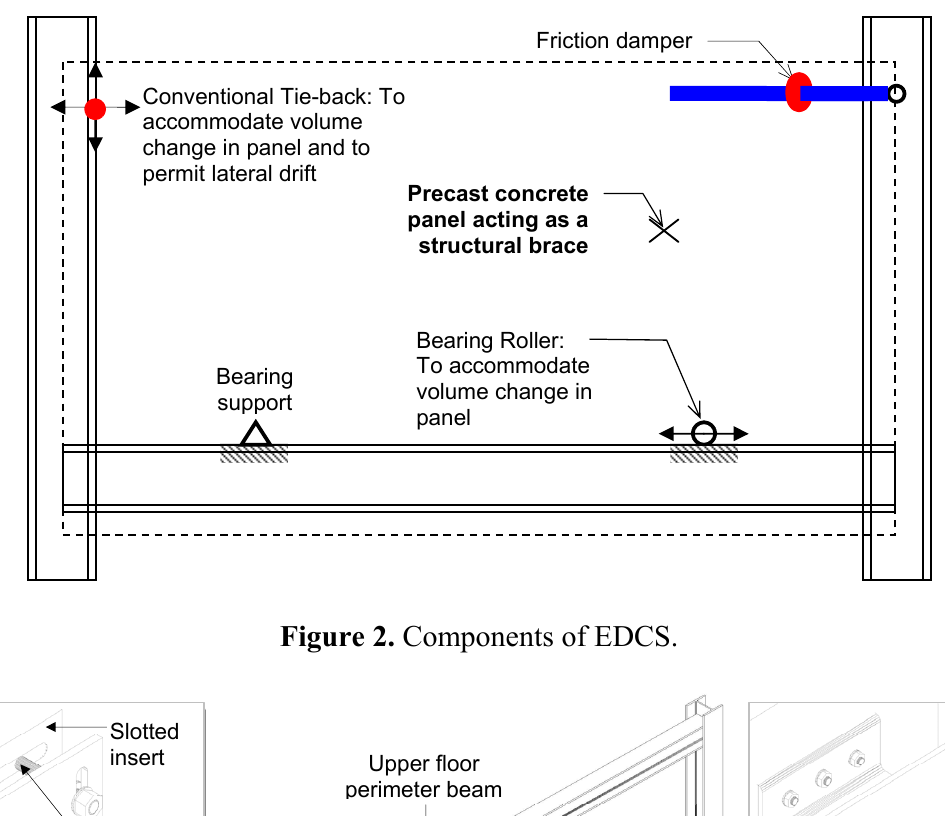
Figure 1. Schematic View of the EDCS.